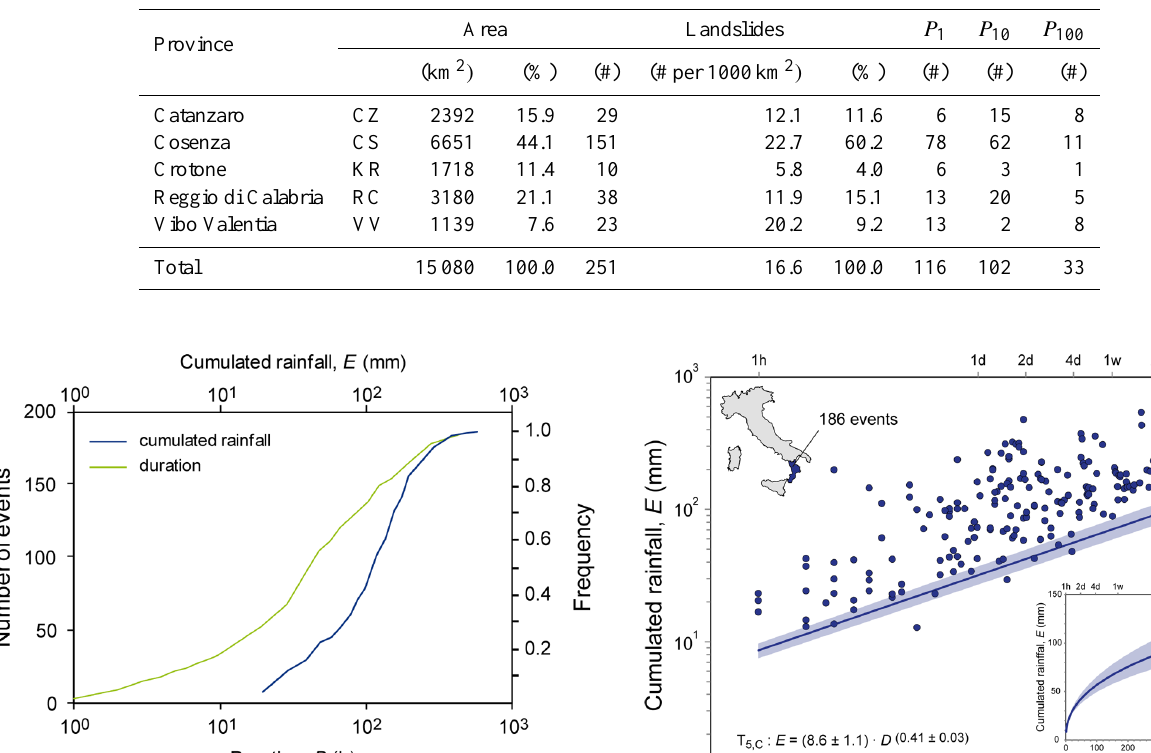
Table 1. Distribution of landslides in the five provinces of Calabria. The last three columns list the number of the landslides mapped for each geographical mapping accuracy class (see text).